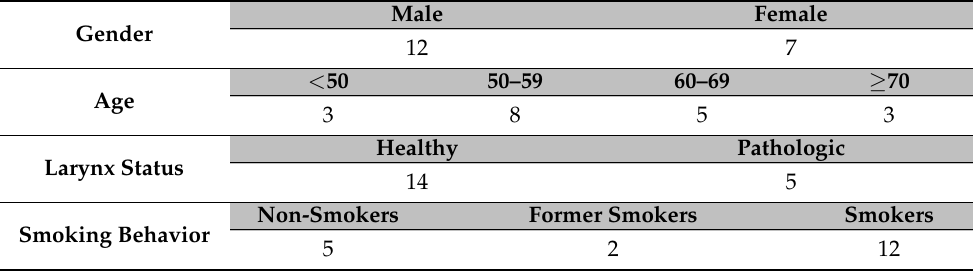
Table 1. Demographic data of the patients belonging to the 19 mucus samples measured by particle tracking microrheology (PTM). Number of evaluated samples based on gender, age, larynx status and smoking behavior.